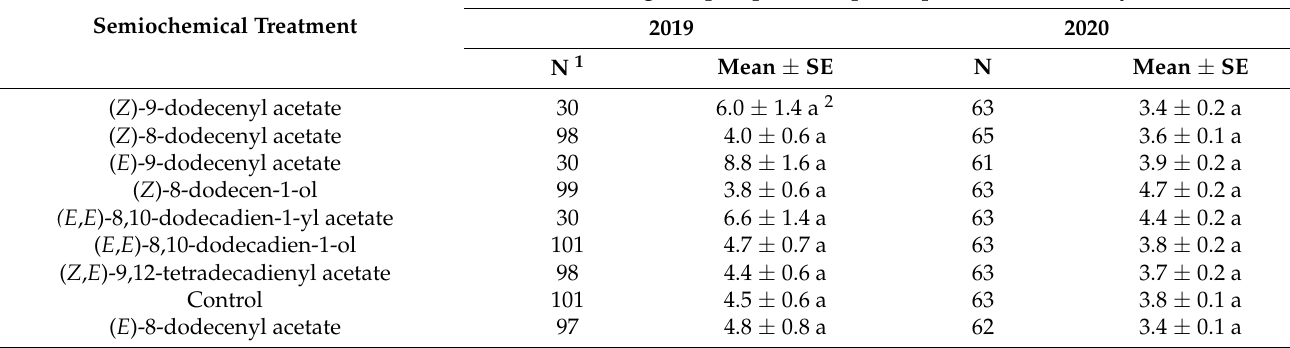
Table 3. Mean (SE) nontarget lepidopteran captures on clear sticky cards changed on a weekly basis during the E. giganteana period of flight in two years from June to August 2019–2021 at the Land Institute in Salina, KS, USA.